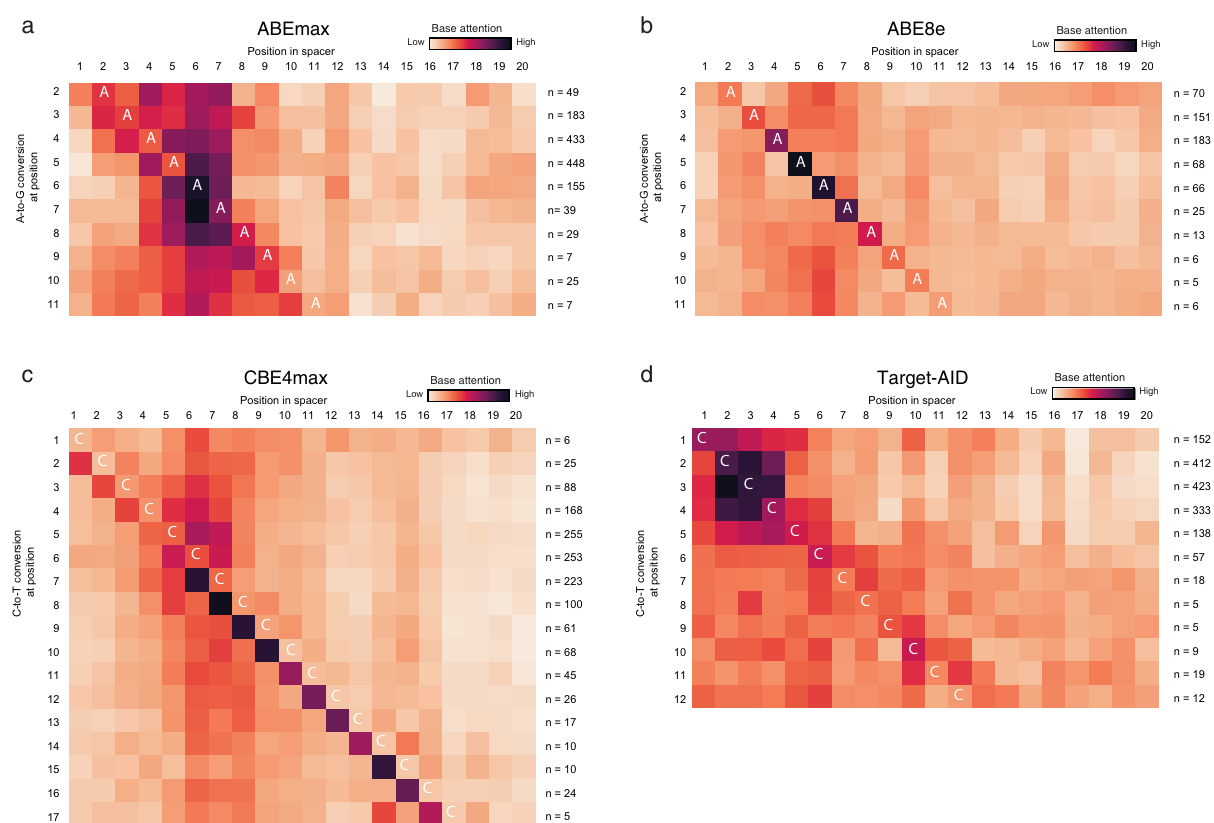
Fig. 4 BE-DICT attention patterns for edited target bases. Attention weight is indicated by color from light to dark. Mean-aggregate attention scores of target sequences (BE-DICT test dataset) predicted to be edited at the respective position for a ABEmax, b CBE4max, c ABE8e, and d Target-AID are shown. The number of sequences used for the analysis of the respective target base position is indicated as n